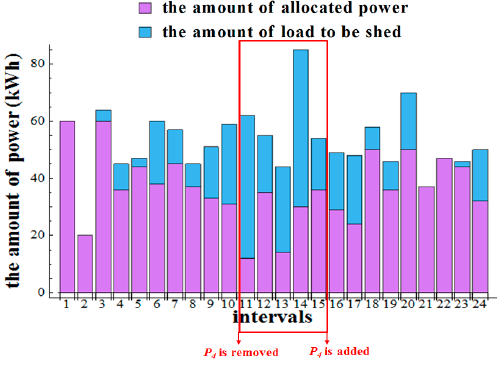
Figure 5. Plug-and-play operation capability.